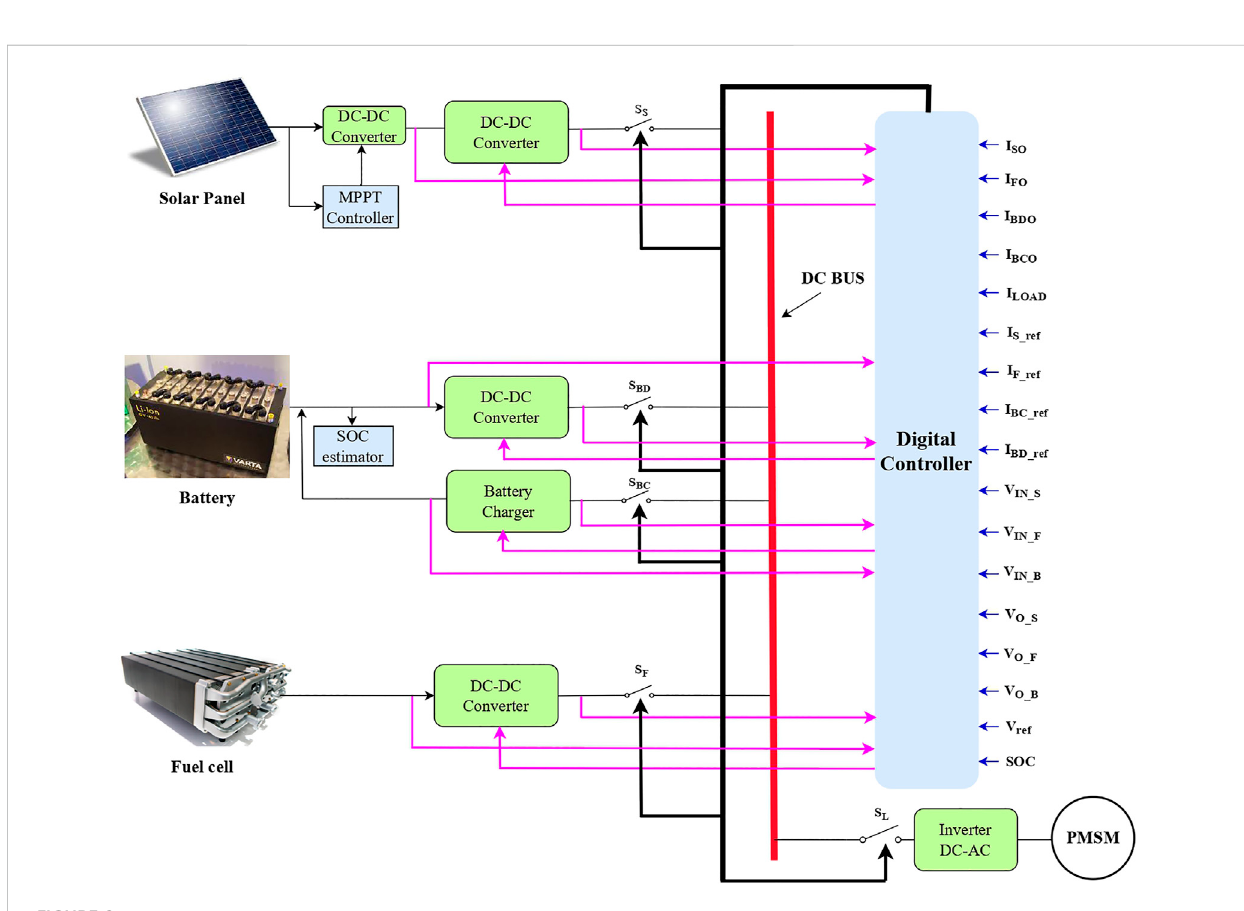
FIGURE 2 Hybrid power source-fed